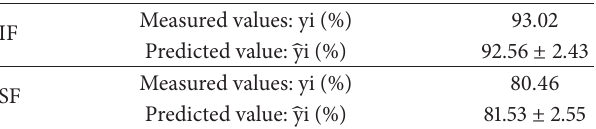
Table 10: Suitability of selected optimal conditions to the measured values.